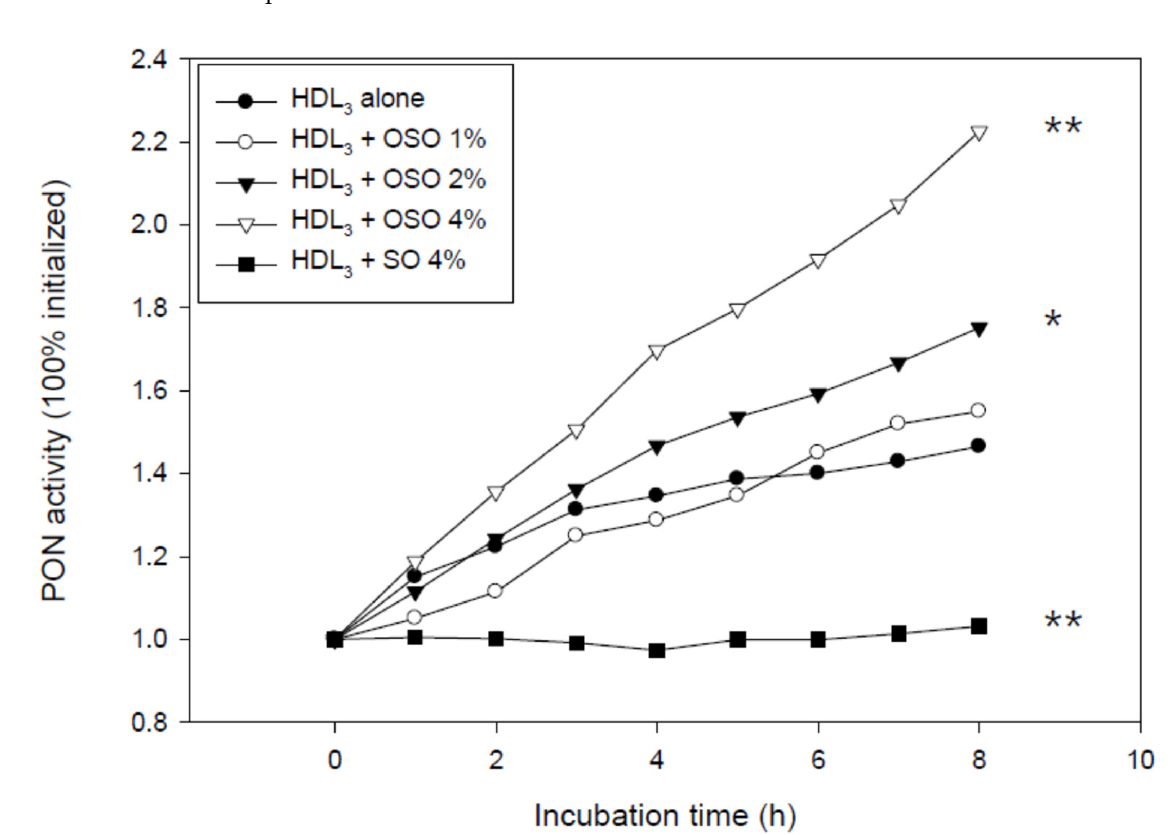
Figure 5. Paraoxonase (PON-1) activity of HDL 3 in the presence of OSO and SO. OSO, ozonated sunflower oil; SO, sun- flower oil; * p < 0.05 compared to HDL 3 alone; ** p < 0.01 compared to HDL 3 alone.